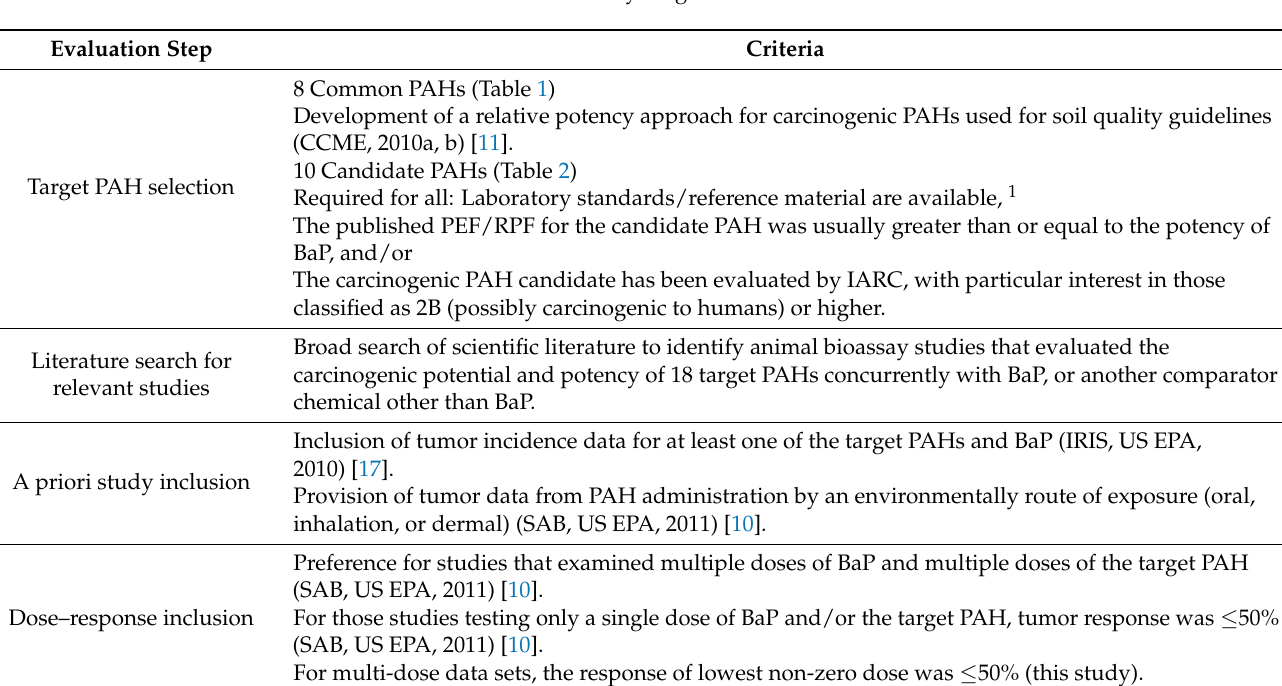
Table 3. Criteria Used to Identify Target PAHs and Studies for Inclusion in PEF